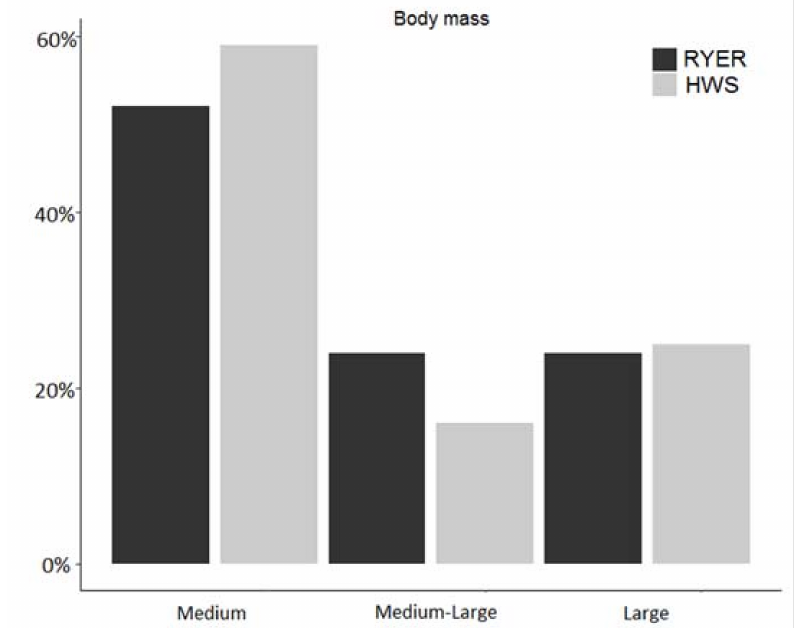
Figure 5. Proportion in % of each body mass groups compared to the total number of observed species in each community (Rakhine Yoma Elephant Range (RYER): black; Htamanthi Wildlife Sanctuary (HWS):